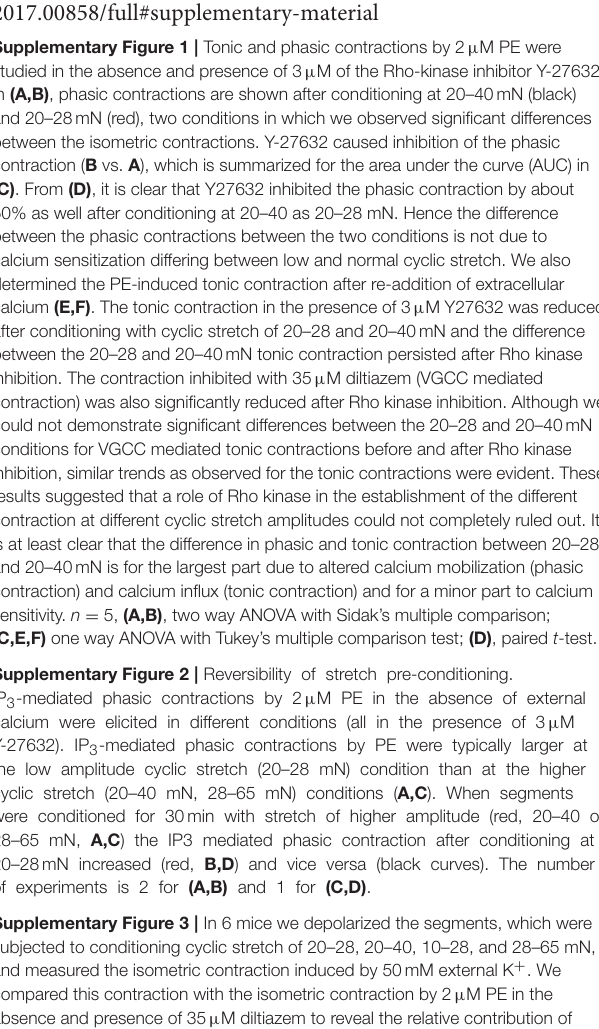
Supplementary Figure 2 | Reversibility of stretch pre-conditioning.